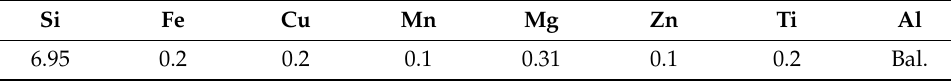
Table 2. Chemical composition of the A356 aluminum alloy (wt.%).